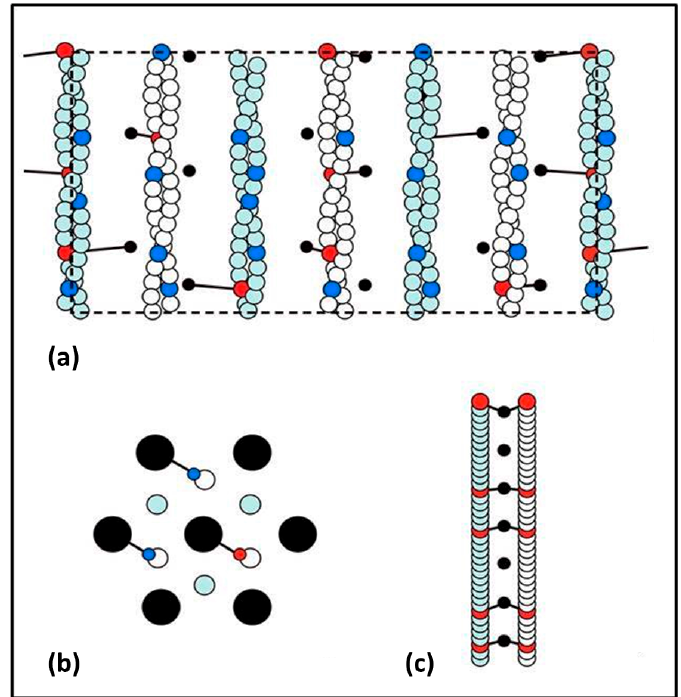
Figure A1. ( a ) Radial projection of a portion of the sarcomere’s A-band. The myosin filament (represented by black circles at the resting positions of the myosin heads on the surface of the backbone) is surrounded by six actin filaments (the actin filaments on the far right and far left represent the same filament). The white actins are equivalent, and so are the light blue ones. The red circles represent actin monomers to which a head is attached. Blue circles represent inaccessible monomers on particular filaments, because a head is already attached there on an equivalent filament. ( b ) Cross-section of the sarcomere A-band. A myosin filament (black circle in the middle) is surrounded by six other myosin filaments. In between there are actin filaments. Monomers with attached heads and equivalent filaments are colour-coded as above. ( c ) One-dimensional Model obtained from ( a ). Black circles represent the myosin backbone and red circles the actin monomers with attached heads. Equivalent actin filaments have been merged together.